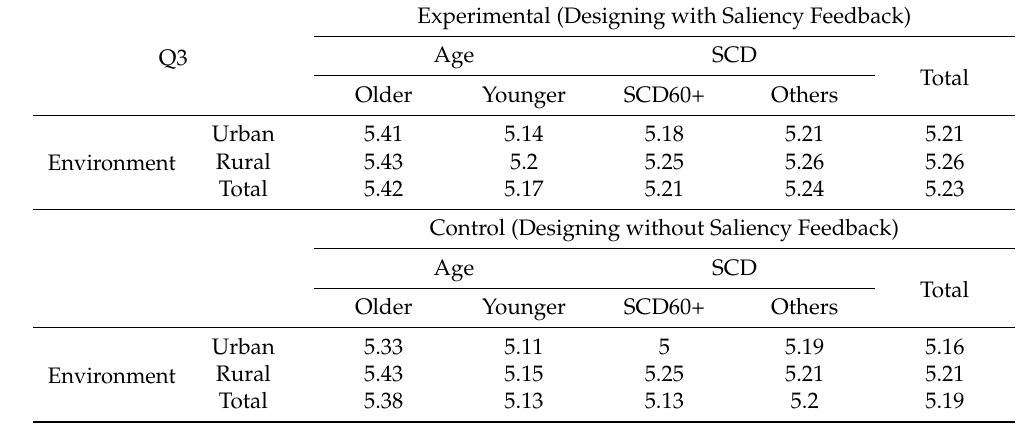
Table A3. Descriptive statistics of the crowd ratings for design quality assessment item Q3 (“suits the